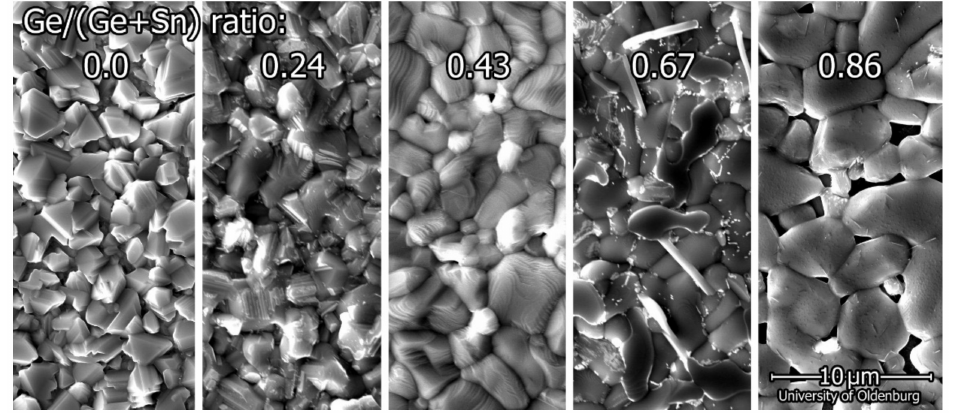
Figure 3. SEM pictures showing the morphology of samples with varied Ge/(Ge + Sn)